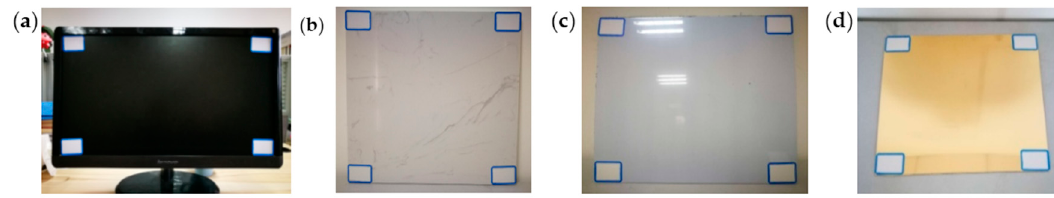
Figure 2. Smooth experimental planar targets: ( a ) computer screen; ( b ) ceramic tile; ( c ) iron sheet; ( d ) polyethylene panel. Four white sheets of paper are attached to each target.